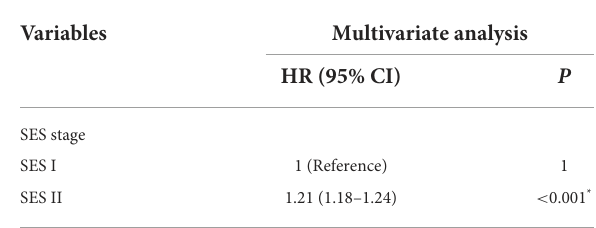
TABLE 4 Multivariate analysis of CSS of patients with